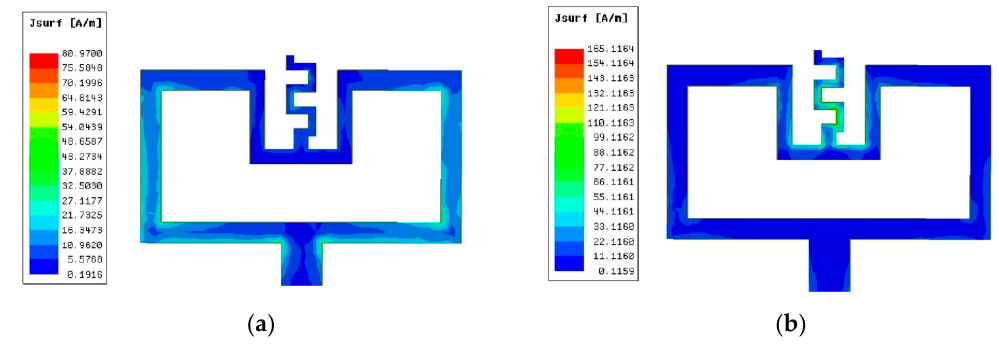
Figure 3. Current distribution of the original antenna at ( a ) 2.45 GHz and ( b ) 5.8 GHz. The meander line stub is adopted since it reduces the size as well as the coupling to the surrounding U ‐ shaped frame. Figure 3b shows the distribution of the current at 5.8 GHz; introducing the stub on the square makes a strong concentration of the current on main radiation part at 5.8 GHz is the meander line stub which is equivalent to a monopole, of the bottom side.